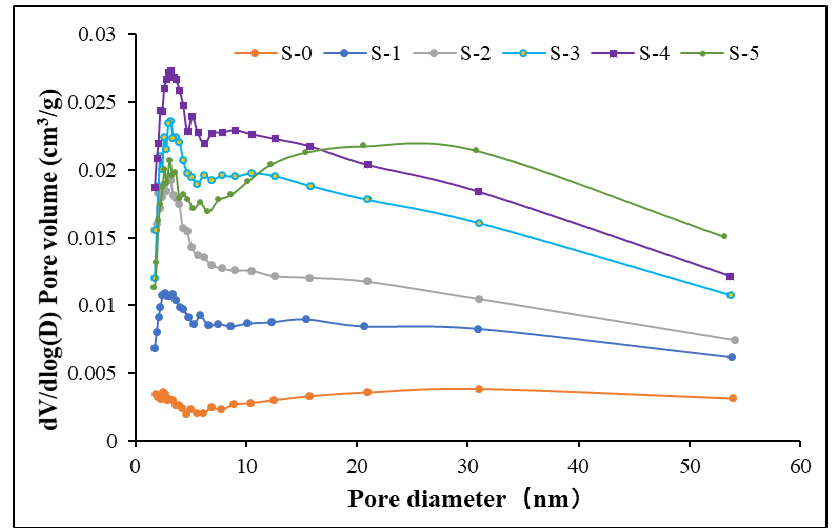
Figure 4. Pore volume distribution of raw and treated shale particles.